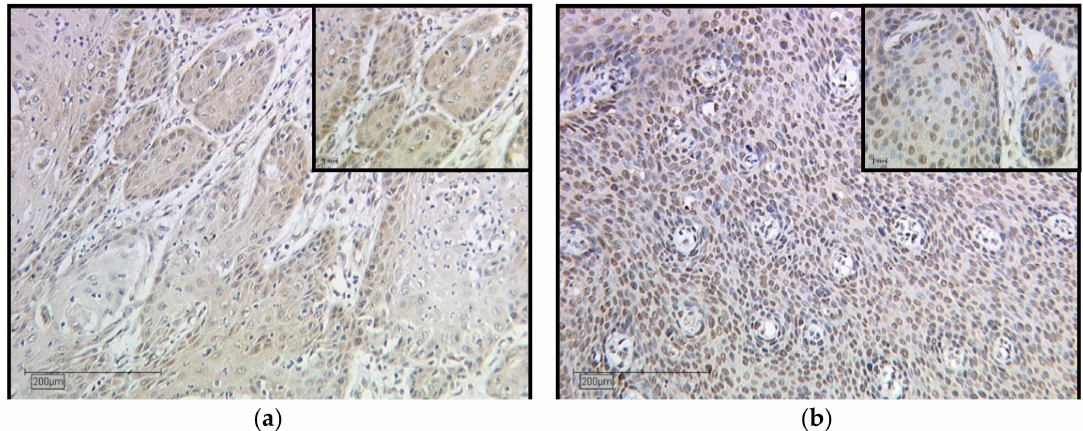
Figure 1. Immunohistochemical staining of LDOC1 in vulvar carcinoma tissue. Representative photomicrographs are presented (10 × and 25 × magnification): ( a ) cytoplasmatic expression of LDOC1